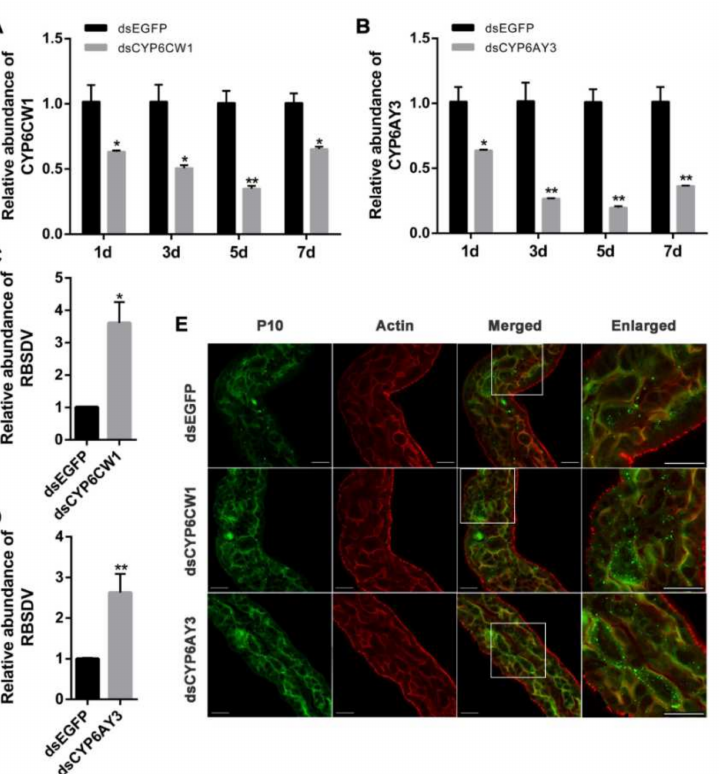
Figure 5. Knockdown of CYP6CW1 and CYP6AY3 increased RBSDV abundance in L. striatellus . ( A , B ) The dsRNAs were injected into VF L. striatellus . One, three, five, and seven days after dsRNA injection, the expression level of CYP6CW1 ( A ) and CYP6AY3 ( B ) were analyzed by RT-qPCR. ( C , D ) CYP6CW1 and CYP6AY3 were knocked down by injecting dsRNA into RBSDV-infected L. striatellus . L. striatellus injected with ds EGFP were included as a control. The virus abundance in RBSDV- infected L. striatellus injected with ds CYP6CW1 ( C ) and ds CYP6AY3 ( D ) was compared with that in control injected with ds EGFP by RT-qPCR. ( E ) RBSDV-infected L. striatellus was injected with dsRNAs and reared on healthy rice seedlings for three days. The virus in the midgut was labeled by immunofluorescence, and the cytoskeleton actin was labeled with phalloidin. The enlarged image shows the area in the square of the merged images. Scale bars, 50 µ m. The asterisk (*) and asterisks (**) indicate p < 0.05 and p < 0.01. Actin representing the cytoskeleton; P10 representing the outer capsid protein of RBSDV; merged representing the composite of Actin and P10; enlarged representing the magnification of the selected area of the merged